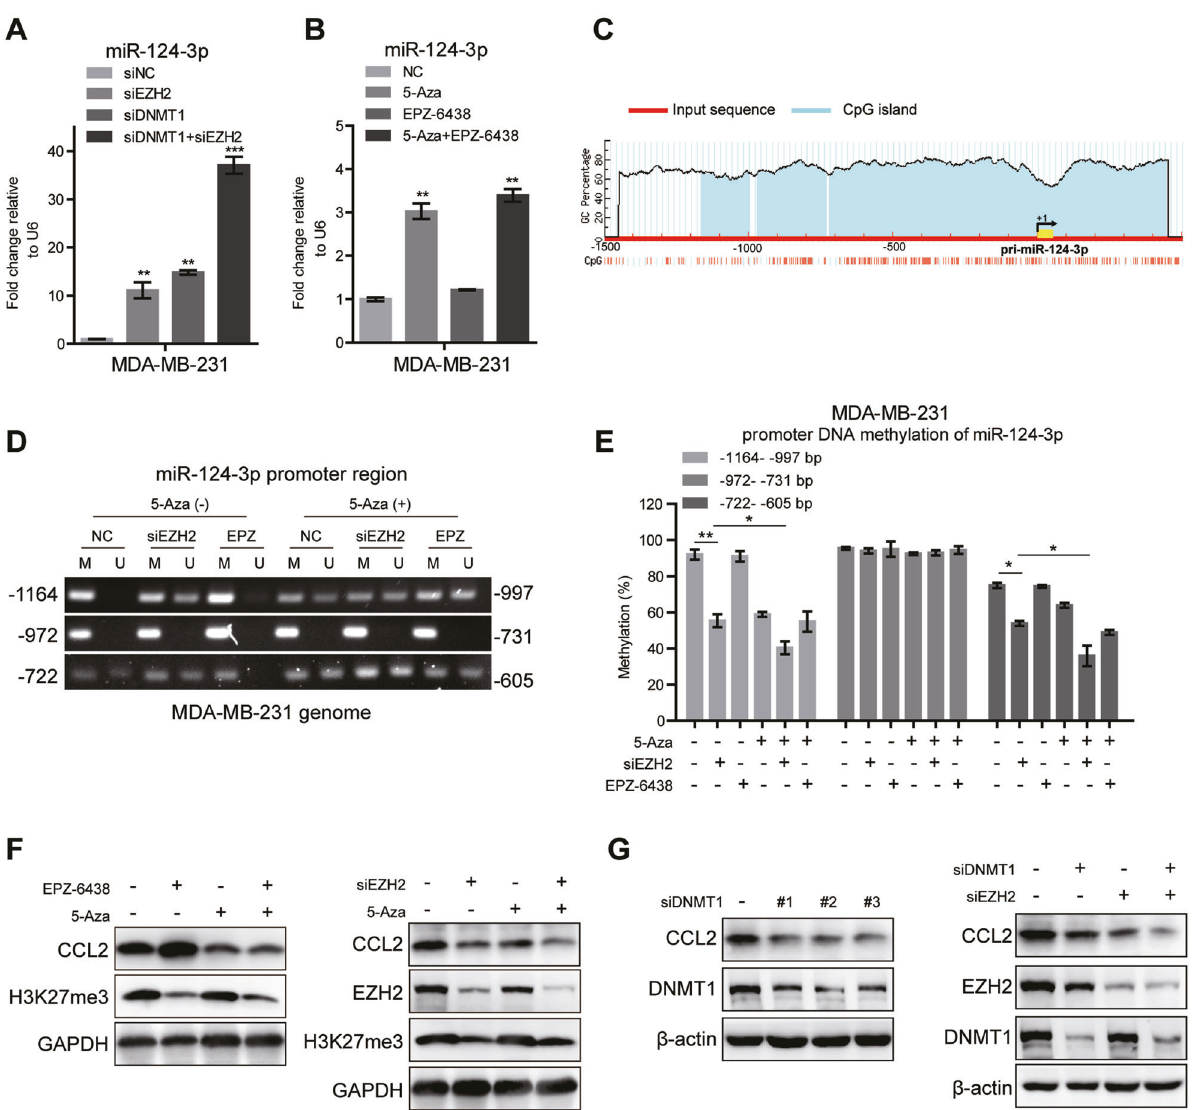
Fig. 5 miR-124-3p is regulated by EZH2 and DNMT1 mediated DNA methylation. A The miR-124-3p level was analyzed by RT-qPCR in MDA- MB-231 cells treated with EZH2 siRNA or/and DNMT1 siRNA for 48 h. U6 was included as a control. n = 3. B The miR-124-3p level was analyzed in MDA-MB-231 cells treated with 5 μ M 5-Aza-CdR (5-Aza) or/and EPZ-6438 for 48 h. U6 was included as a control. n = 3. C Modi fi ed output of MethPrimer program (Li and Dahiya, 2002). Coordinates are given in relation to the transcription start site (TSS). A large CpG island ( − 1200 to + 450 bp, blue region) is evident in the upstream of the gene. Vertical lines indicate relative positions of CpG dinucleotides. D 5-Aza-CdR (5- Aza) and EZH2 siRNA treatment decreased the DNA methylation level of miR-124-3p promoter region ( − 1164 to − 997 and − 722 to − 605bp) in MDA-MB-231 cells analyzed by MSP. The relative percentages of the methylation were quanti fi ed due to the PCR results E . F The CCL2 levels were analyzed by western blot in MDA-MB-231 cells treated with 5-Aza and EZH2 siRNA or 5-Aza and EPZ-6438 for 48 h. G The CCL2 levels were analyzed by western blot in MDA-MB-231 cells treated with siDNMT1 and siEZH2 for 48 h. The shown were representative of replicates and the experiments were repeated three times. In ( A , B and E ), all data were shown as mean values ± SD ( n = 3). Statistical signi fi cance was addressed using unpaired, two ‐ tailed Student ’ s t ‐ test, * p < 0.05, ** p < 0.01, *** p < 0.001, NS not signi fi cant. The statistical signi fi cance was calculated compared to the negative control (NC) in each